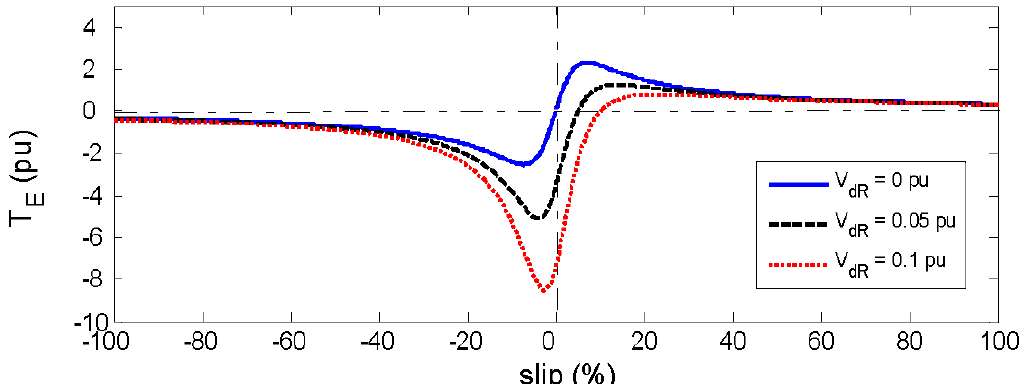
Figure 7. Electromagnetic torque curve vs. slip of wound rotor induction machine for different values of V . dR